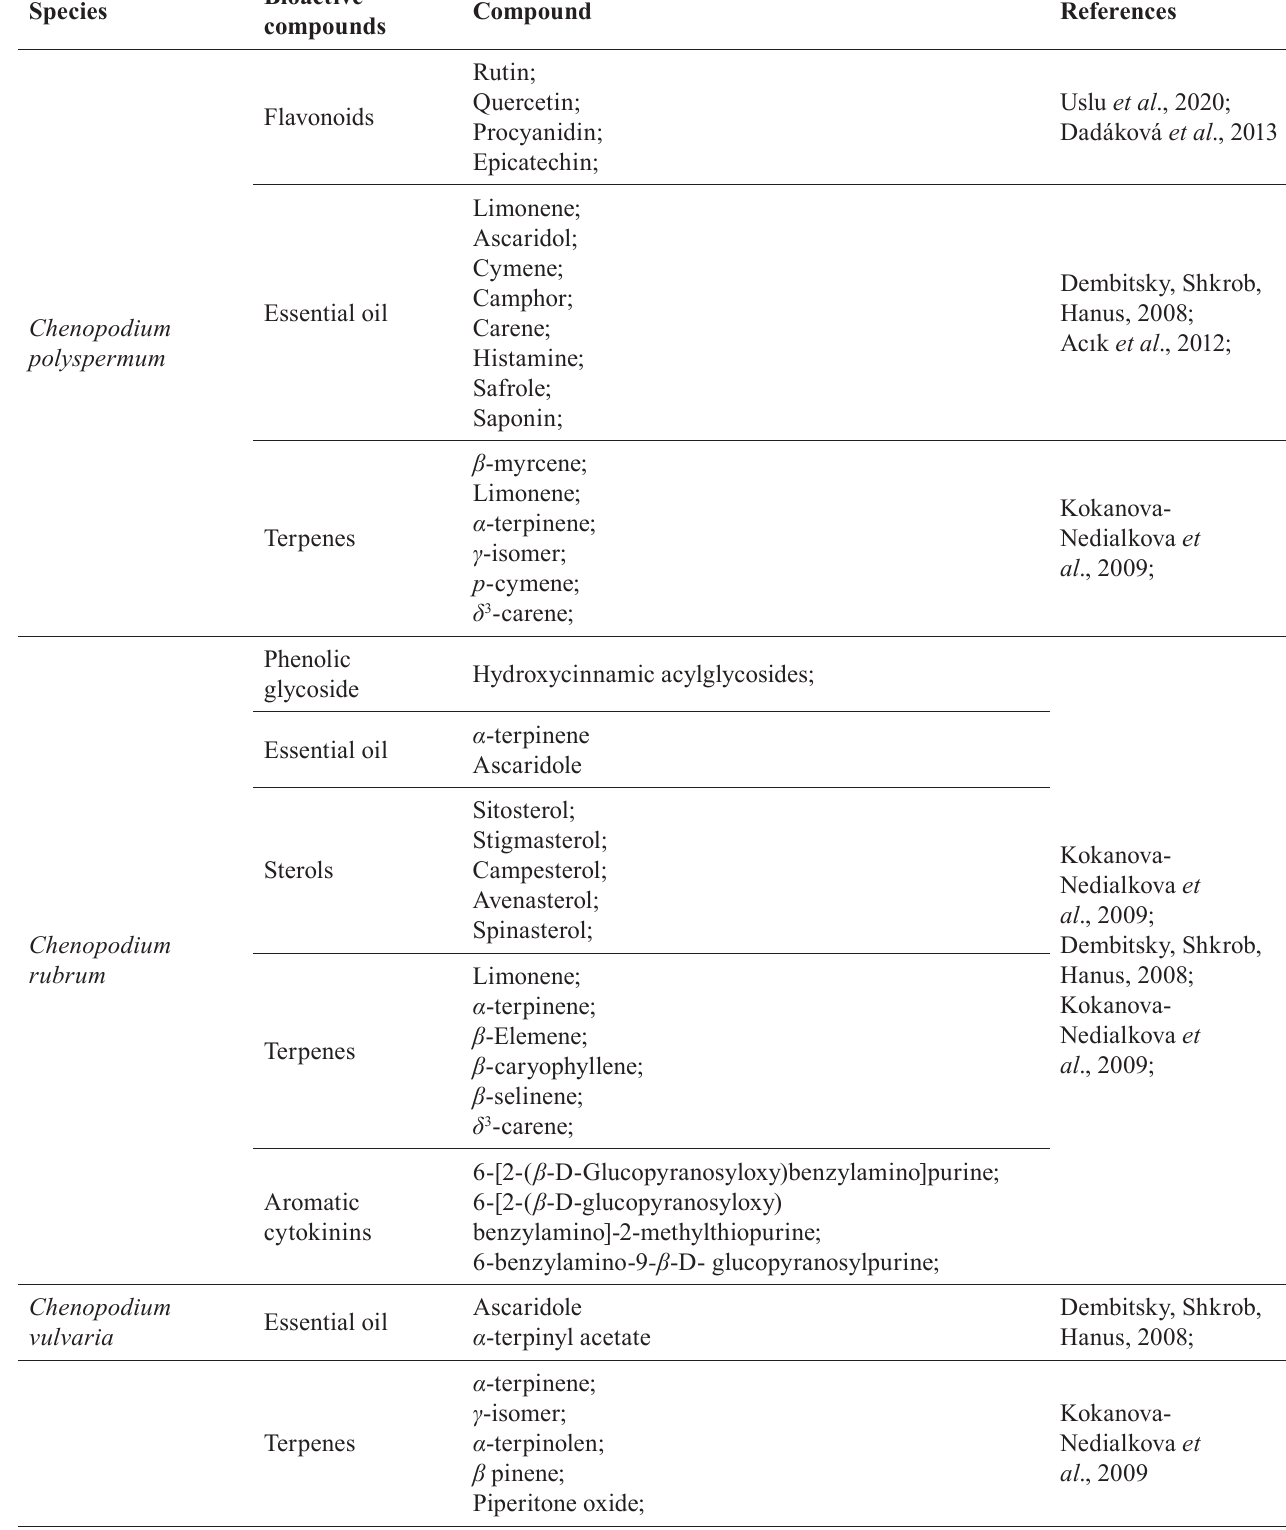
TABLE I - S econdary metabolites of presented halophytic Amaranthaceae species